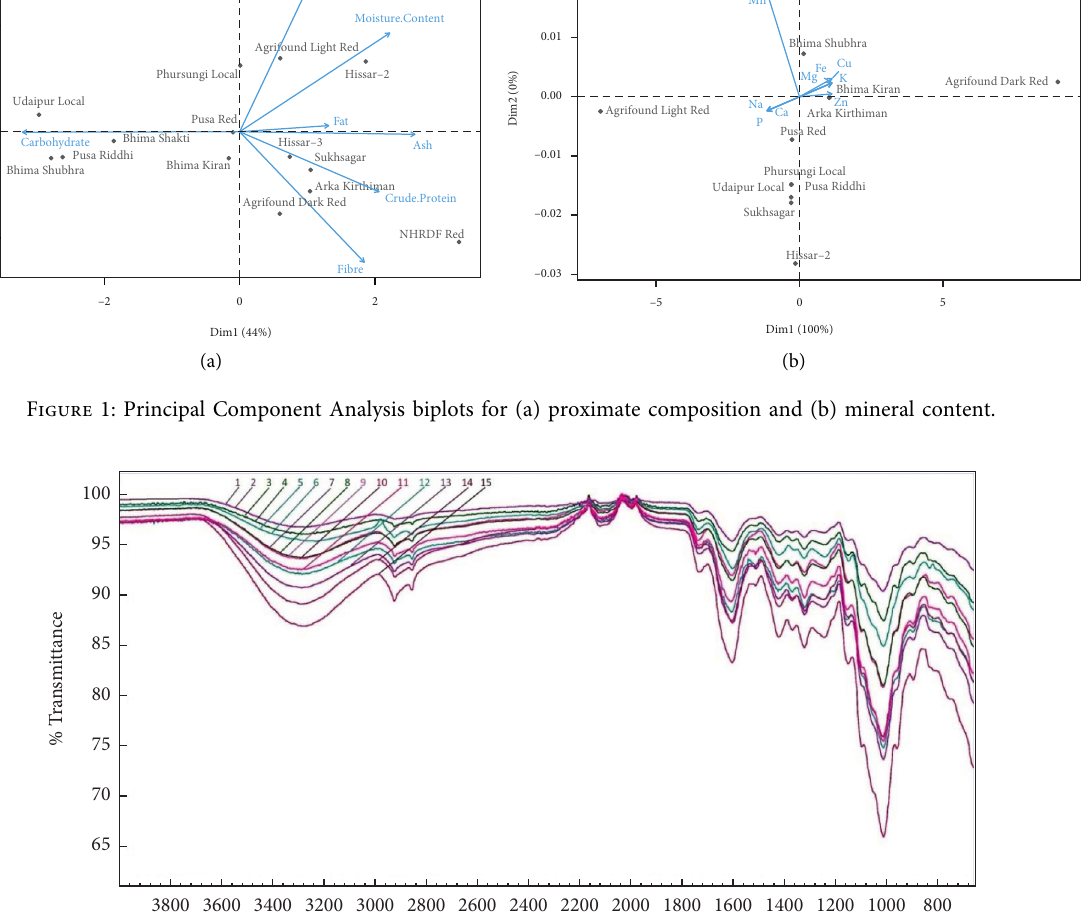
Figure 2: IR spectra of onion skin powder of fifteen cultivars: 1, Agrifound Dark Red; 2, Agrifound Light Red; 3, Arka Kirthiman; 4, Bhima Kiran; 5, Bhima Shakti; 6, Bhima Shubhra; 7, Hissar-2; 8, Hissar-3; 9, NHRDF Red; 10, Phursungi Local; 11, Pusa Madhavi; 12, Pusa Red; 13, Pusa Riddhi; 14, Sukhsagar; 15, Udaipur Local.